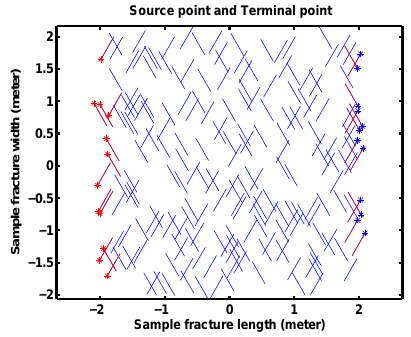
Figure 7. The start vertex and terminal vertex of discrete fracture